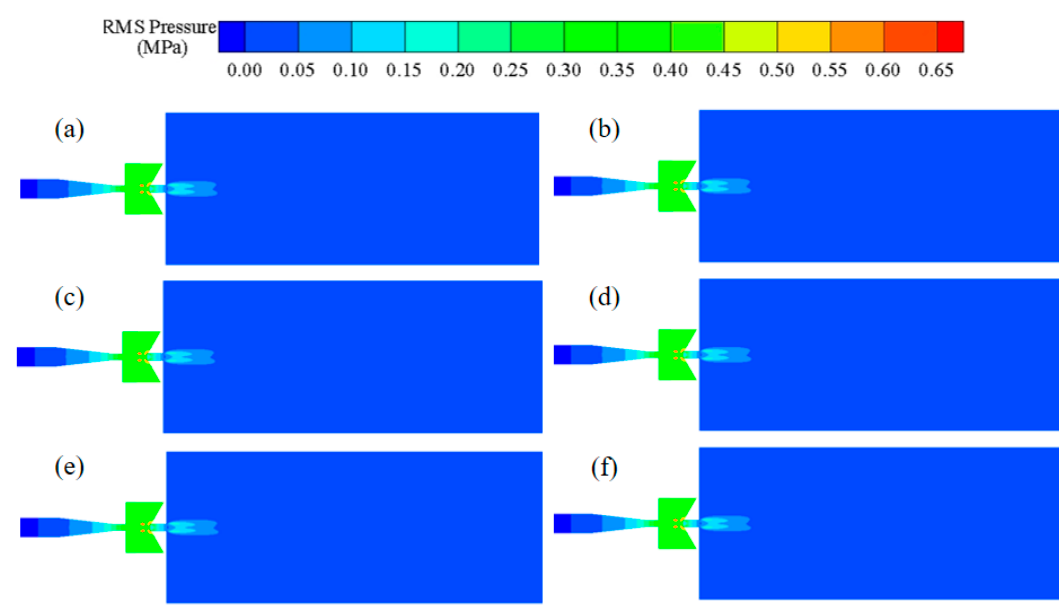
Figure 8. RMS (root mean square) pressure variation of SEOPJ at different time ( Δ t = 5 ms). ( a ) t = t 0 + Δ t ; ( b ) t = t 0 + 2 Δ t ; ( c ) t = t 0 + 3 Δ t ; ( d ) t = t 0 + 4 Δ t ; ( e ) t = t 0 + 5 Δ t ; ( f ) t = t 0 + 6 Δ t .